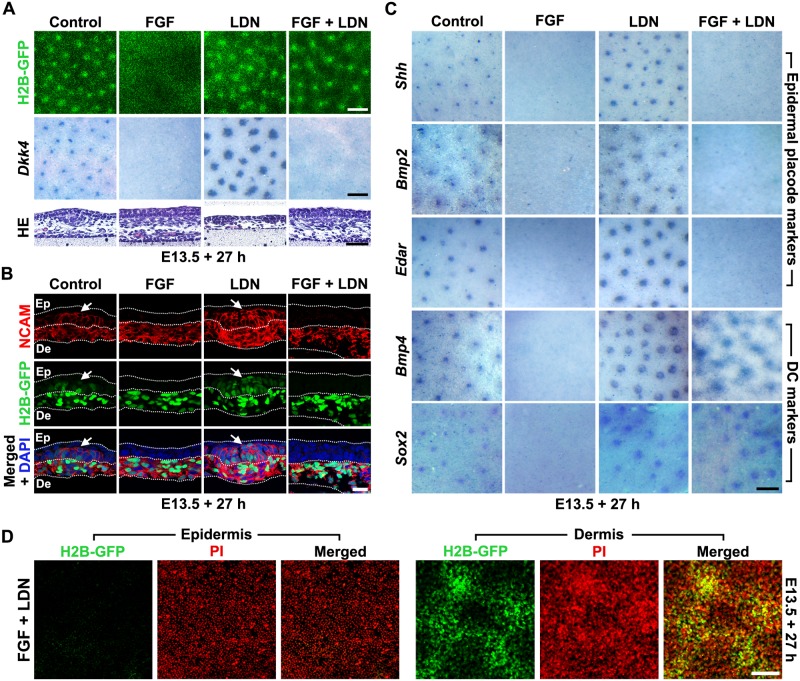
Spatially patterned dermal condensates can form in the absence of epidermal placodes.(A) Detection of green fluorescent protein (GFP) signal, Dkk4 expression, and histological appearance of TCF/Lef::H2B-GFP skin explants cultured with fibroblast growth factor (FGF) 9 (1 μg/ml), LDN193189 (LDN) (10 μM), or both agents. Large, periodically spaced dermal condensates form in the absence of epidermal placodes when FGF and LDN are administered. Scale bars: H2B-GFP & Dkk4: 250 μm, haemotoxylin and eosin (HE): 50 μm. (B) Frozen sections of TCF/Lef::H2B-GFP dorsal skin explants treated as indicated and stained for neural cell adhesion molecule (NCAM) expression. Arrows indicate epidermal placode. Scale bar: 20 μm. (C) Expression of epidermal placode (Shh, Edar, Bmp2) and dermal condensate (Bmp4, Sox2) marker genes in dorsal skin explants cultured with FGF and LDN. Scale bar: 250 μm. (D) Epidermis and dermis isolated from E13.5 TCF/Lef::H2B-GFP skin explants cultured with FGF9 and LDN, counterstained with propidium iodide (PI) and imaged using confocal microscopy. Epidermis is unpatterned while the large dermal condensates are accompanied by cell depletion from the intervening spaces. Scale bar: 100 μm.